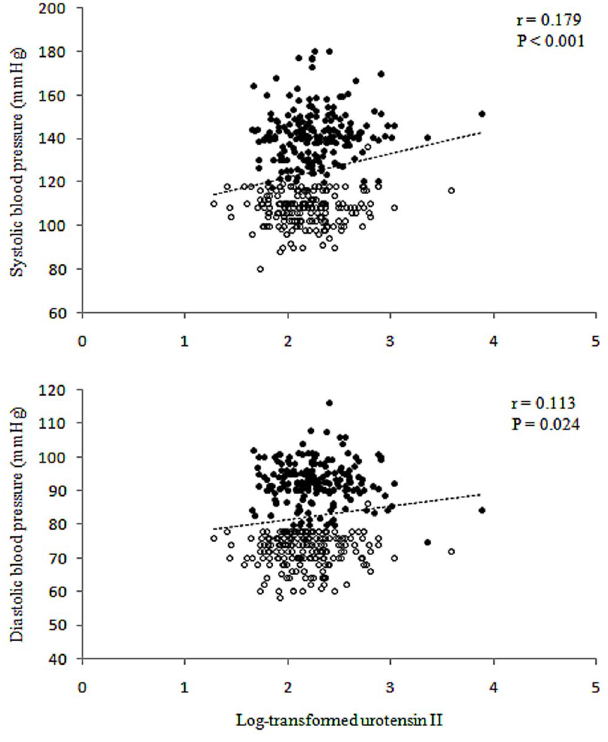
Figure 1. Correlation between plasma urotensin II and blood pressure. Closed circles represent hypertensive patients and open circles represent normotensive subjects.